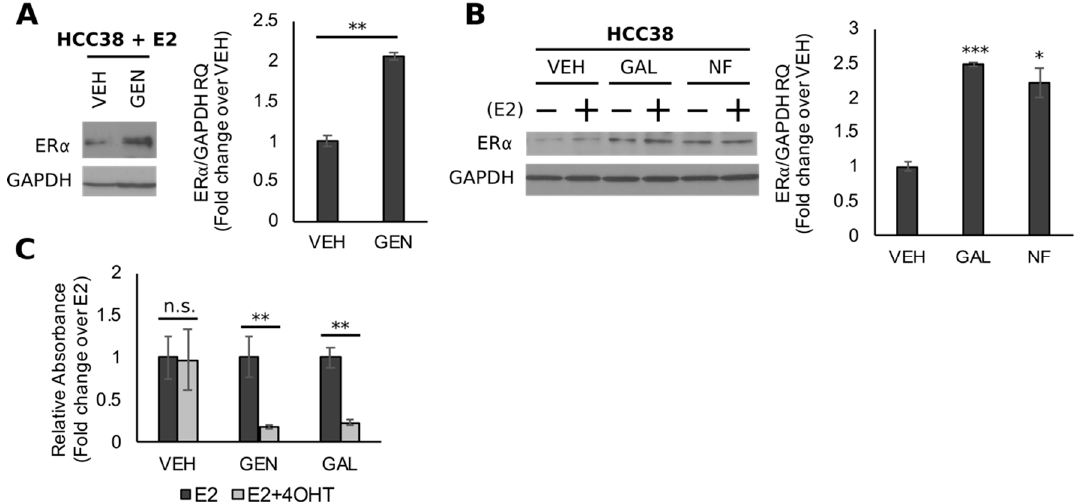
Figure 6. Genistein upregulates ER α expression and sensitizes TNBC cells to 4-OHT. Bands represent immunocomplexes for ER α and internal standard GAPDH in HCC38 cells treated with ( A ) GEN, ( B ) NF, or GAL. Images are representative blots from ≥ 3 individual experiments. Blots are shown with quantitation by densitometry. Bars represent sample means ± SEM from ≥ 3 biological replicates from individual experiments ( C ) Results from 3-(4,5-dimethylthiazol-2-yl)-2,5-diphenyltetrazolium bromide (MTT) assay in HCC38 cells pre-treated with GEN. Bars represent mean relative absorbance at 570 nm ± SEM from 3 ( n = 3) independent experiments. Asterisks denote significance (*, p < 0.05; **, p < 0.01; ***, p <